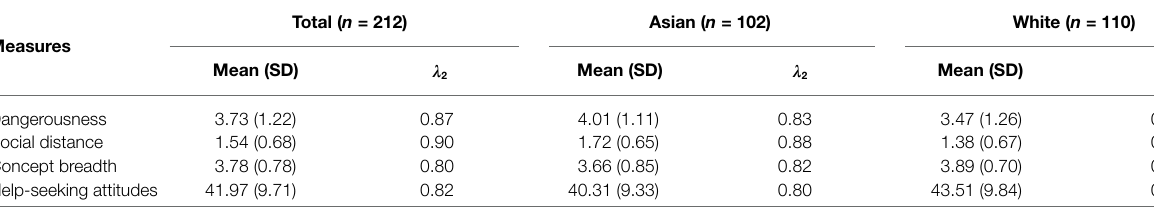
TABLE 1 | Descriptive statistics and reliability estimates of all measures.